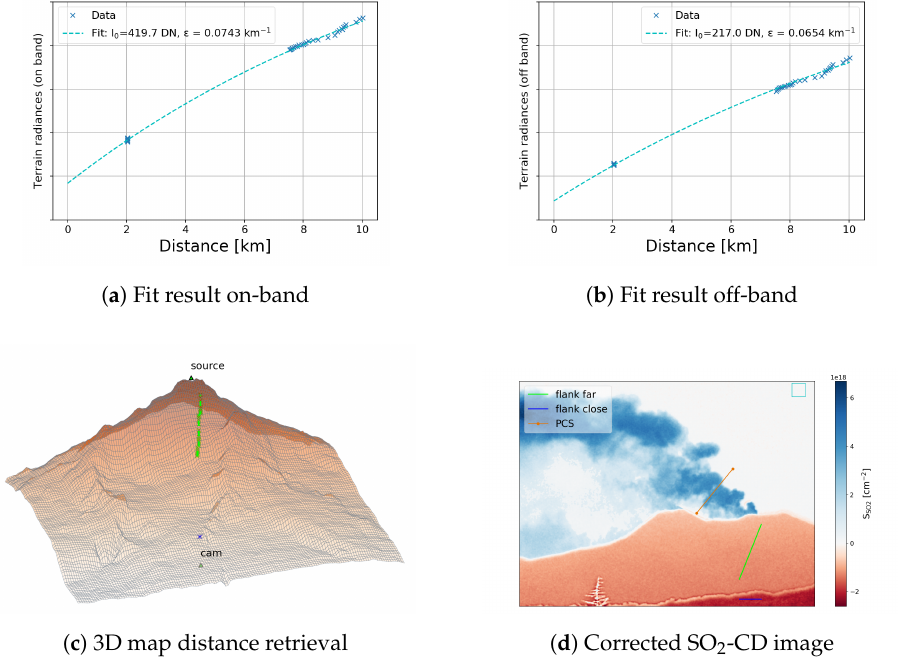
Figure 10. Signal dilution correction. ( a ) and ( b ) show the fit results of an example dilution analysis for the on and off-band regime, respectively; ( c ) shows a 3D map of the camera scene and ( d ) a dilution corrected SO 2 -CD image. The terrain features used for the dilution analysis are indicated in (c) and ( d ) (blue and lime coloured lines); ( d ) further includes the image region used to estimate the ambient intensity I A (blue rectangle) and an example PCS line used to compare emission rates before and after the